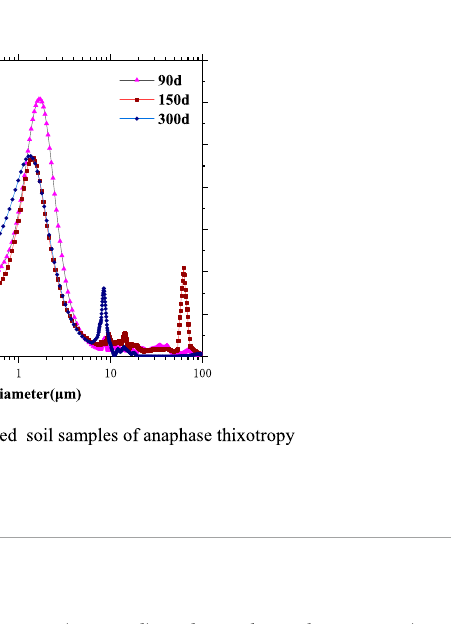
Figure 9. It can be seen from Figure 9A that the pore distribution curve of the undisturbed soil sample is characterized by one main peak and multiple sub-peaks. The pore diameter distribution range of